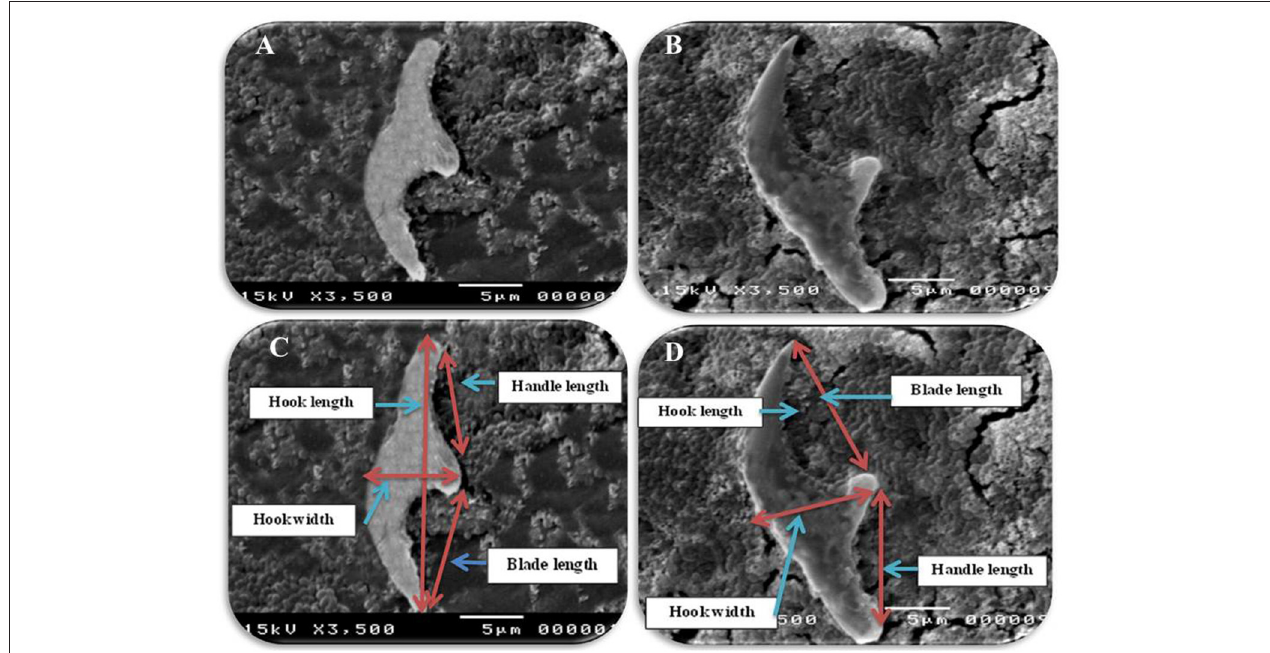
FIGURE 3 | Morphometric appearance of small and large hook of hydatid cyst isolated from lung of camel using SEM. (A) The small hook of hydatid cyst. (B) The large hook of hydatid cyst. (C) Measurement the small hook of hydatid cyst; total hook length = 27 µ m (arrow), total hook width = 9 µ m (arrow), handle length = 9 µ m (arrow) and blade length = 10 µ m (arrow) and (D) measurement the large hook of hydatid cyst; Total hook length = 34 µ m (arrow), total hook width = 12 µ m (arrow), handle length = 14 µ m (arrow) and blade length = 15 µ m